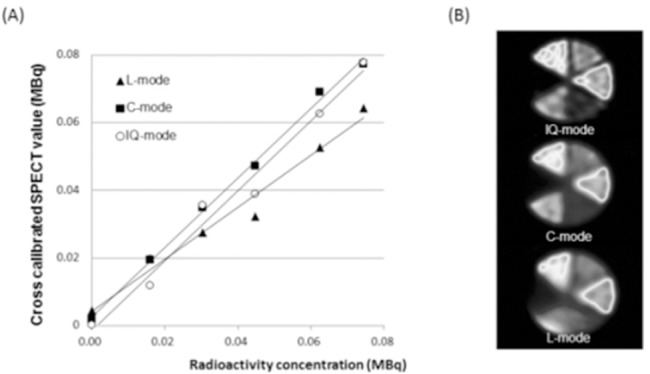
Linear regression analysis and pai phantom SPECT images.(A) Linear regression analysis shows relationship between relative SPECT counts and relative radioactivity concentrations for C-, L- and IQ-modes.(B) Pai phantom SPECT images. Top, IQ-mode; middle, C-mode; bottom, L-mode.